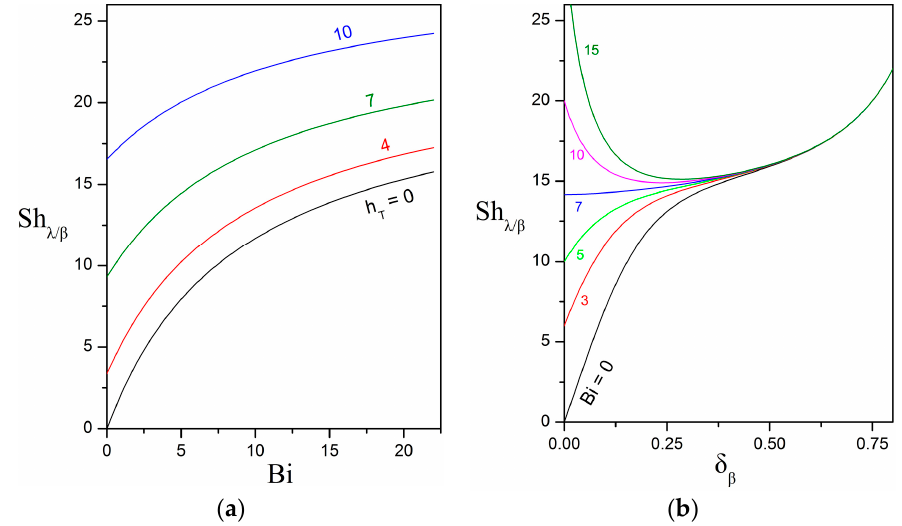
Figure 3. Dependence of the overall Sherwood number on: ( a ) the Biot and Thiele numbers for δ β = 0.1; and ( b ) the dimless biofilm thickness and the Biot number for h T = 6. Also, Λ A β =